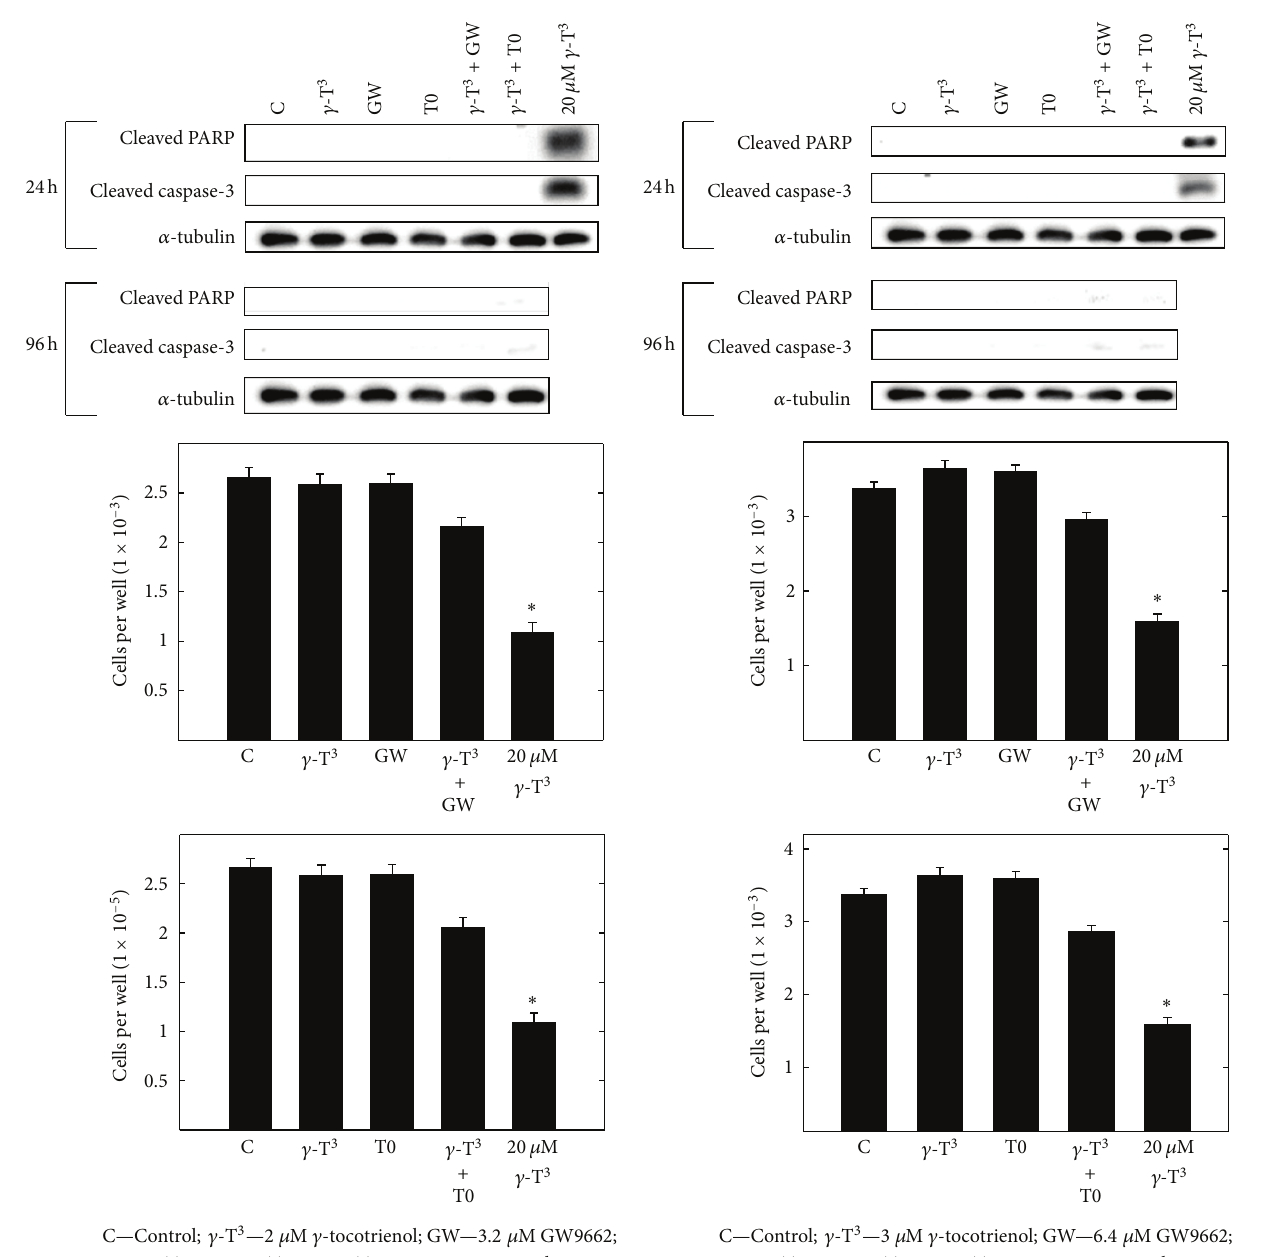
F 11: Apoptotic effects of -tocotrienol and PPAR antagonists (GW9662 or T0070907) alone or in combination on caspase-3 and cleaved PARP levels on (a) MCF-7 and (b) MDA-MB-231 human breast cancer cells. For Western blot studies, MCF-7 and 𝛾𝛾 𝛾𝛾